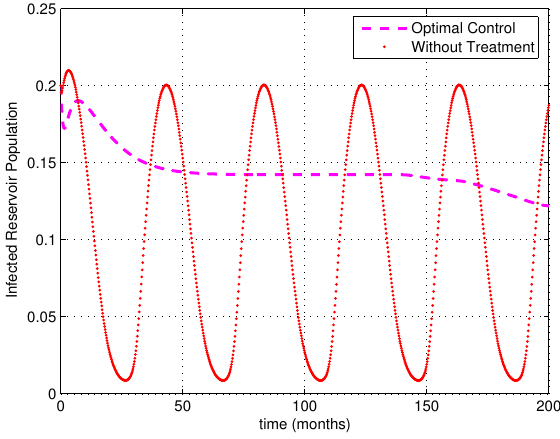
Figure 2. Simulation results showing the infected reservoir.